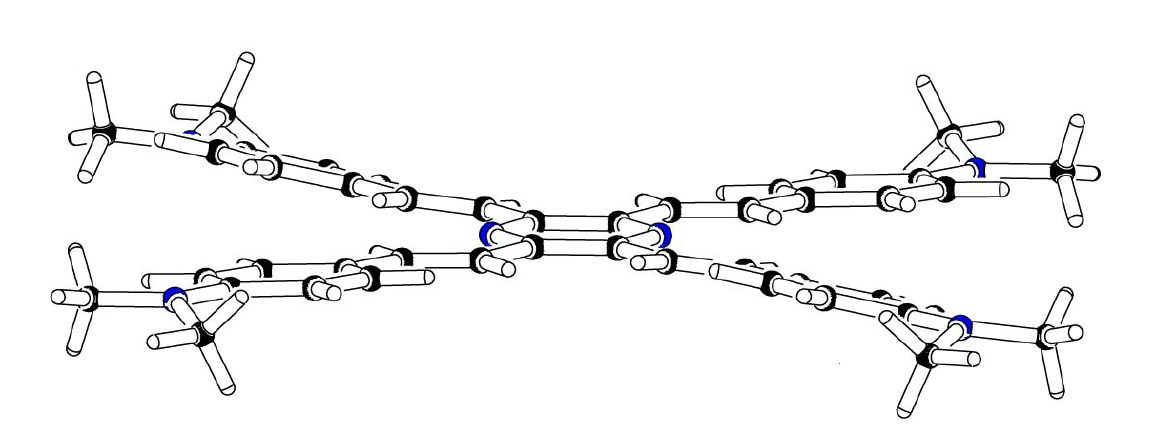
Figure 29. X-ray structure of 2,3,5,6-tetrakis( p -dimethylaminostyryl)pyrazine 92a